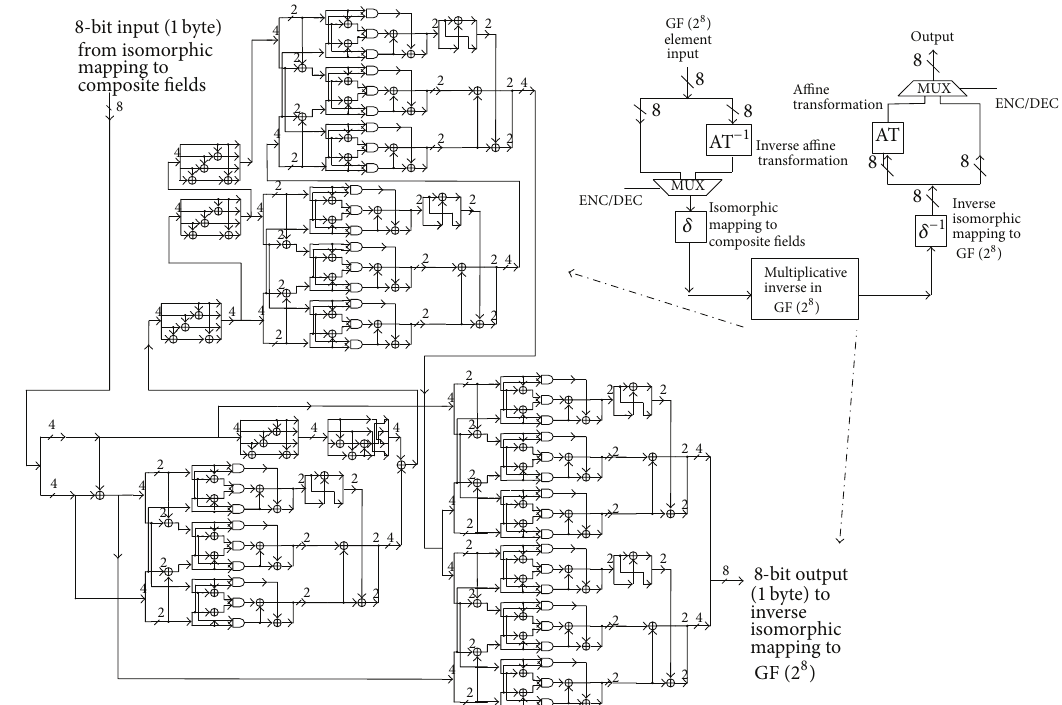
Figure 8: The schematic circuit for the multiplicative inverse of GF (2 8 ) of the SubBytes